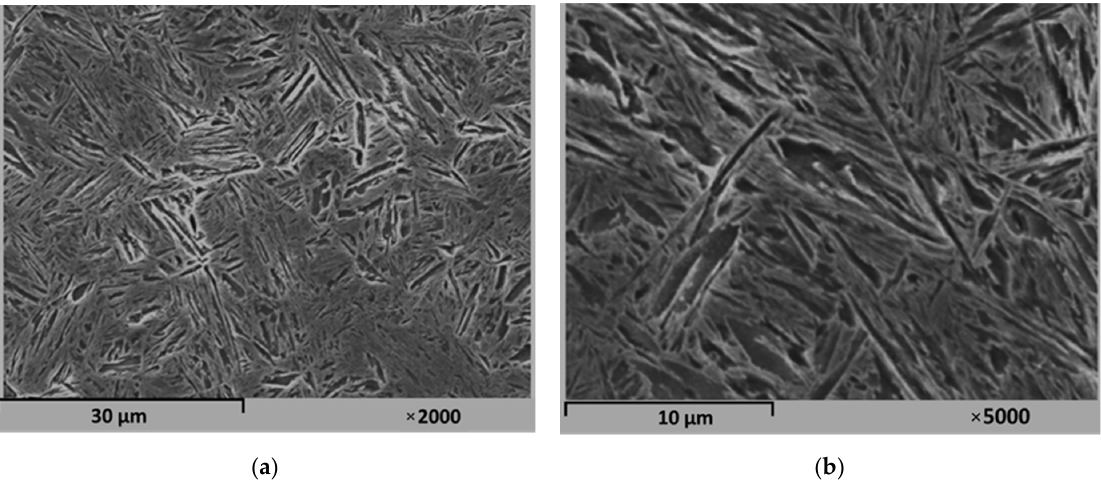
Figure 2. Microstructure of a round-rolled sample from 40KhN2MA grade steel after austenitization at a temperature of 850 °C for 45 min and subsequent oil quenching: ( a ) magnification ×2000 and ( b ) magnification ×5000.